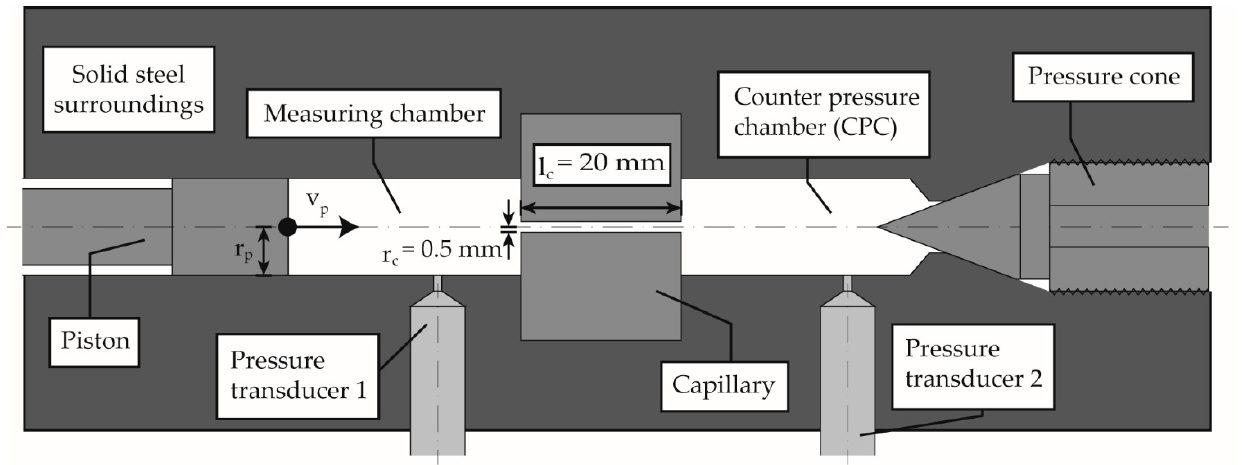
Figure 1. Measuring setup of the high-pressure capillary rheometer (HPC) with closed counter pressure chamber (CPC) according to [38]. Reprinted with permission from ref. [38]. Copyright 2020 Copyright Polymers.